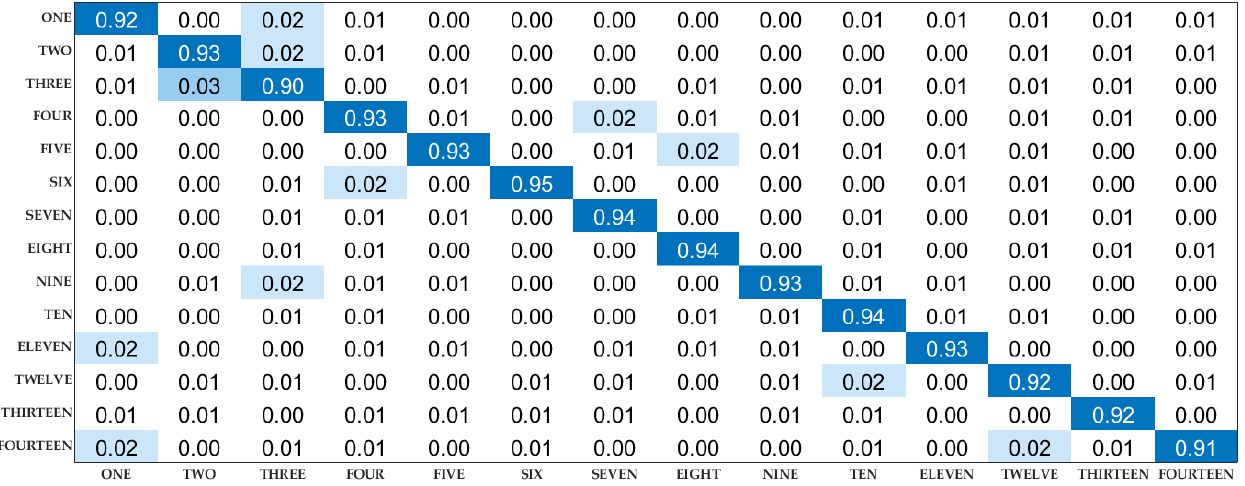
Figure 16. Confusion matrix for synthesizing experimental results.